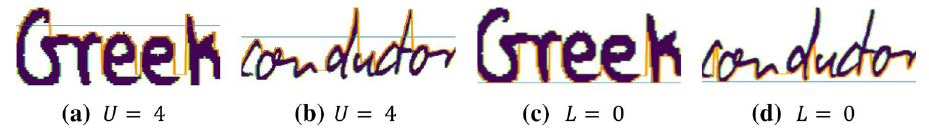
Fig. 8 The number of times the upper and lower profiles of a word image cuts the modified upper and lower boundaries of the dense region. a U = 4 U = 4 L = 0 L = b c d